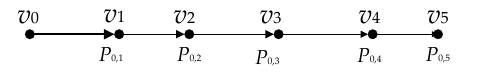
Figure 3. Six relays between the edge node and the core